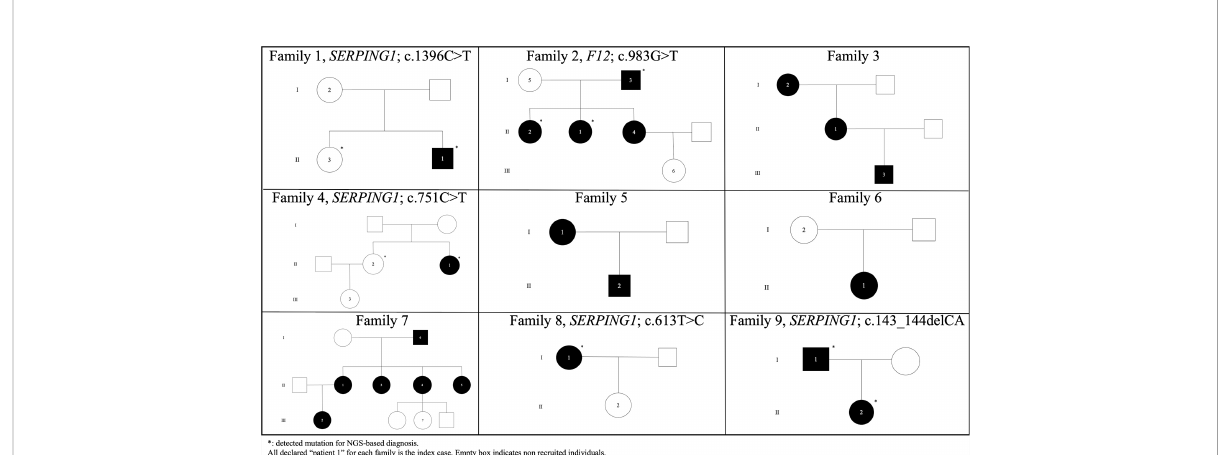
FIGURE 2 Pedigrees of unrelated HAE families in the Canary Islands.